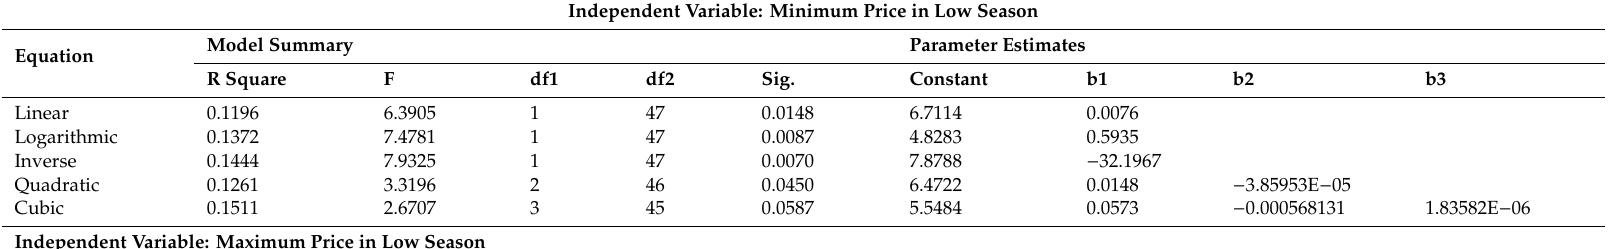
Table 12. Model summary and parameter estimates of regression analysis in Agadir destination with Q as dependent